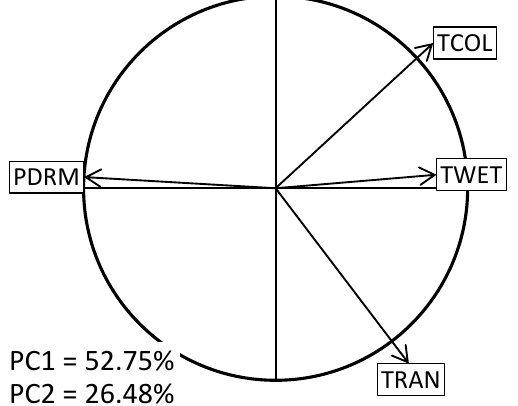
Figure 2. Two-dimensional environmental space, determined by the two main axes of a PCA from four descriptor variables. TCOL , minimum temperature of the coldest month; TRAN , temperature annual range; TWET , mean temperature of the wettest quarter; PDRM , precipitation of the driest